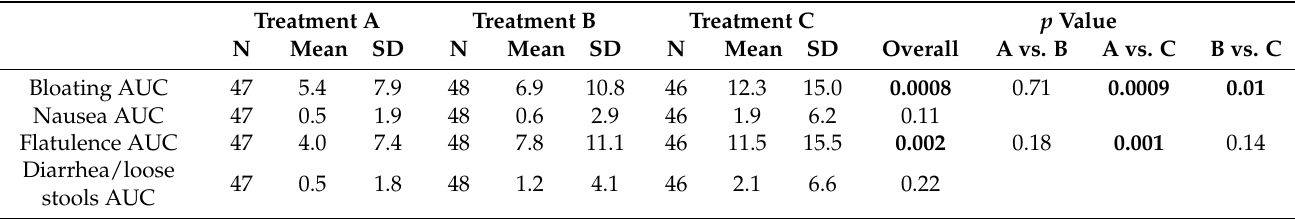
Table 1. Gastrointestinal tolerance and